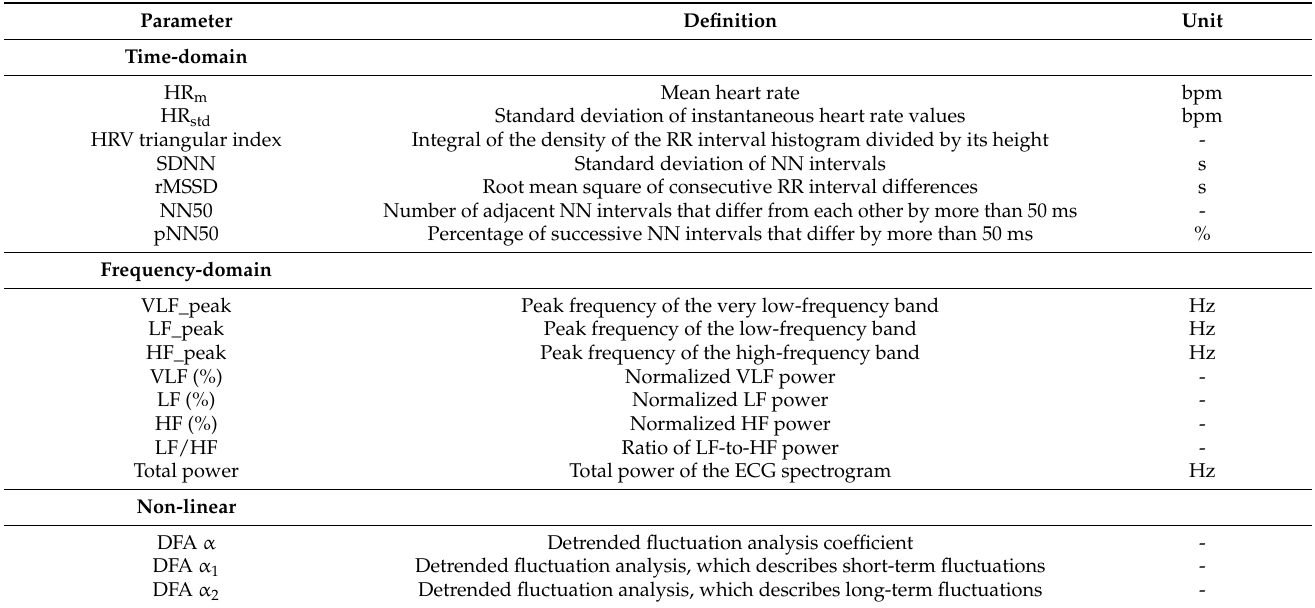
Table 3. HRV parameters measured in full- and pre-term